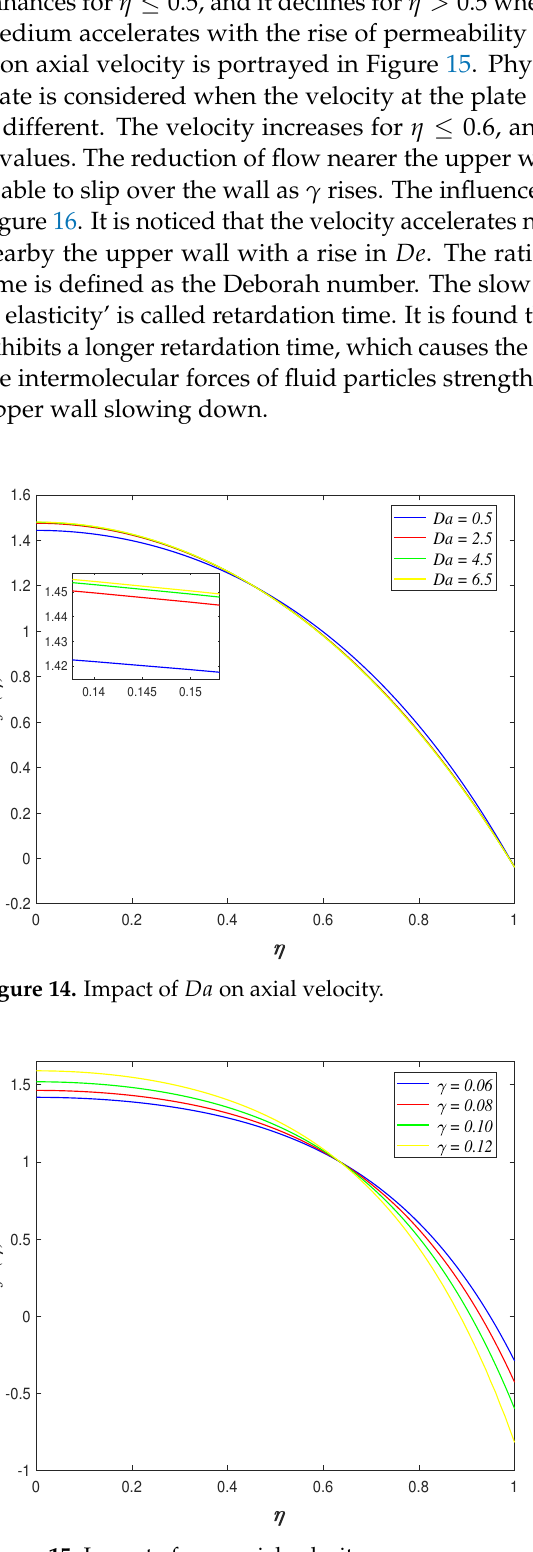
Figure 15. Impact of γ on axial